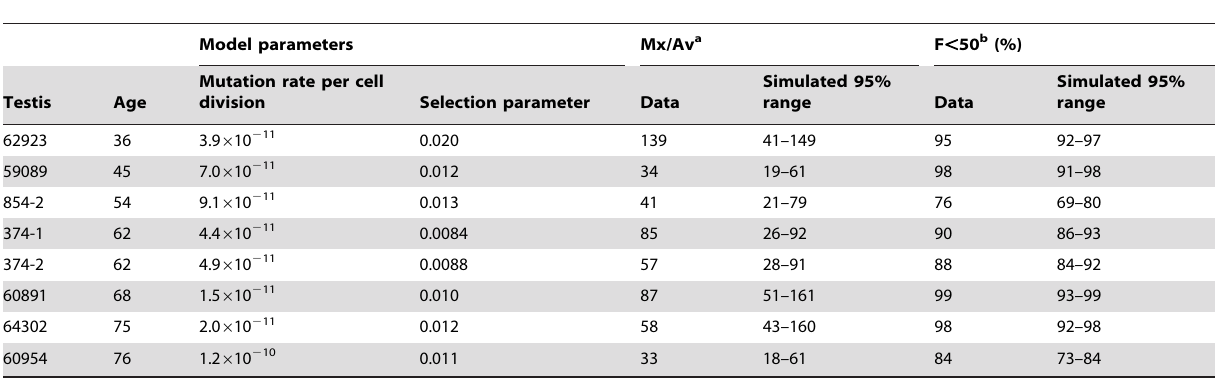
Table 4. Selection model incorporating cell death model parameters and simulation results for those testes with substantial MEN2B mutation